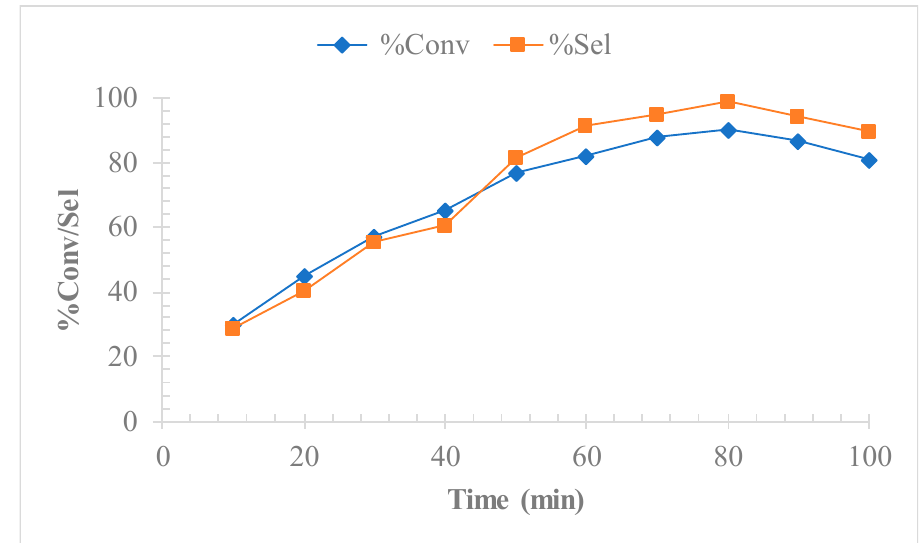
Figure 4. Time effect on percent conversion and selectivity of CA to CD with Ag-Co/S as a catalyst. Conditions of Reaction: CA; 1 mmol, Cat; 25 mg, Stirring speed; 750 rpm, oxidant; O 2 (760 torr), and temperature; 75 °C.